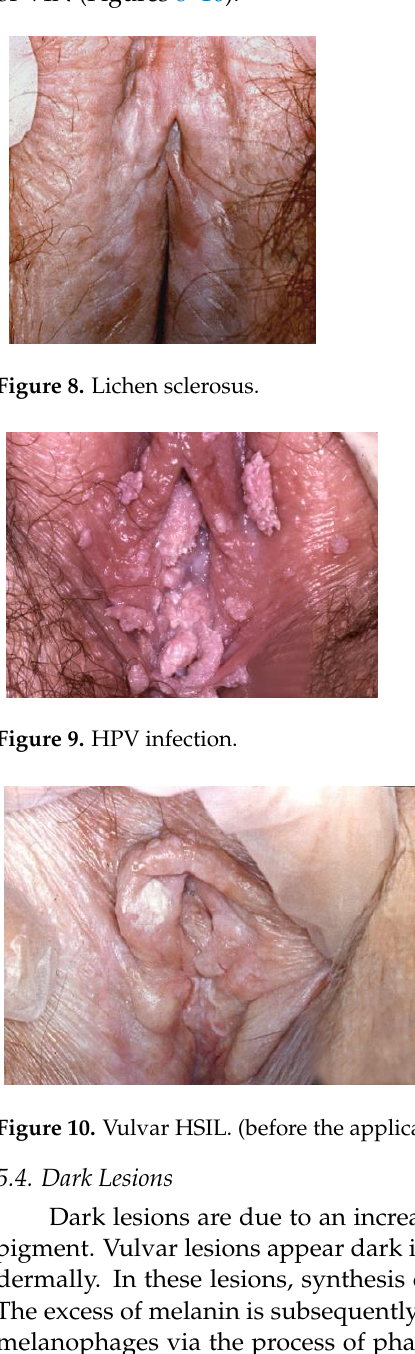
8 of 17 Figure 6. Paget’s disease. Figure 7. Invasive cancer. 5.3. White Lesions White lesions are not always neoplastic. A superficial keratin layer, any degree of